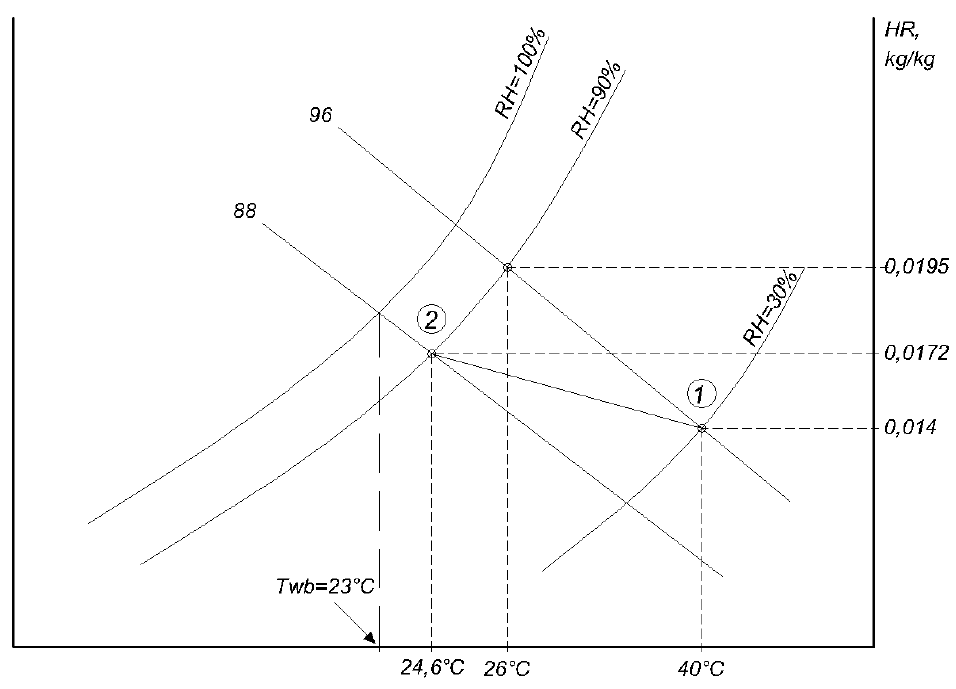
Figure 4. Schemes of psychrometric chart for cases parameters.